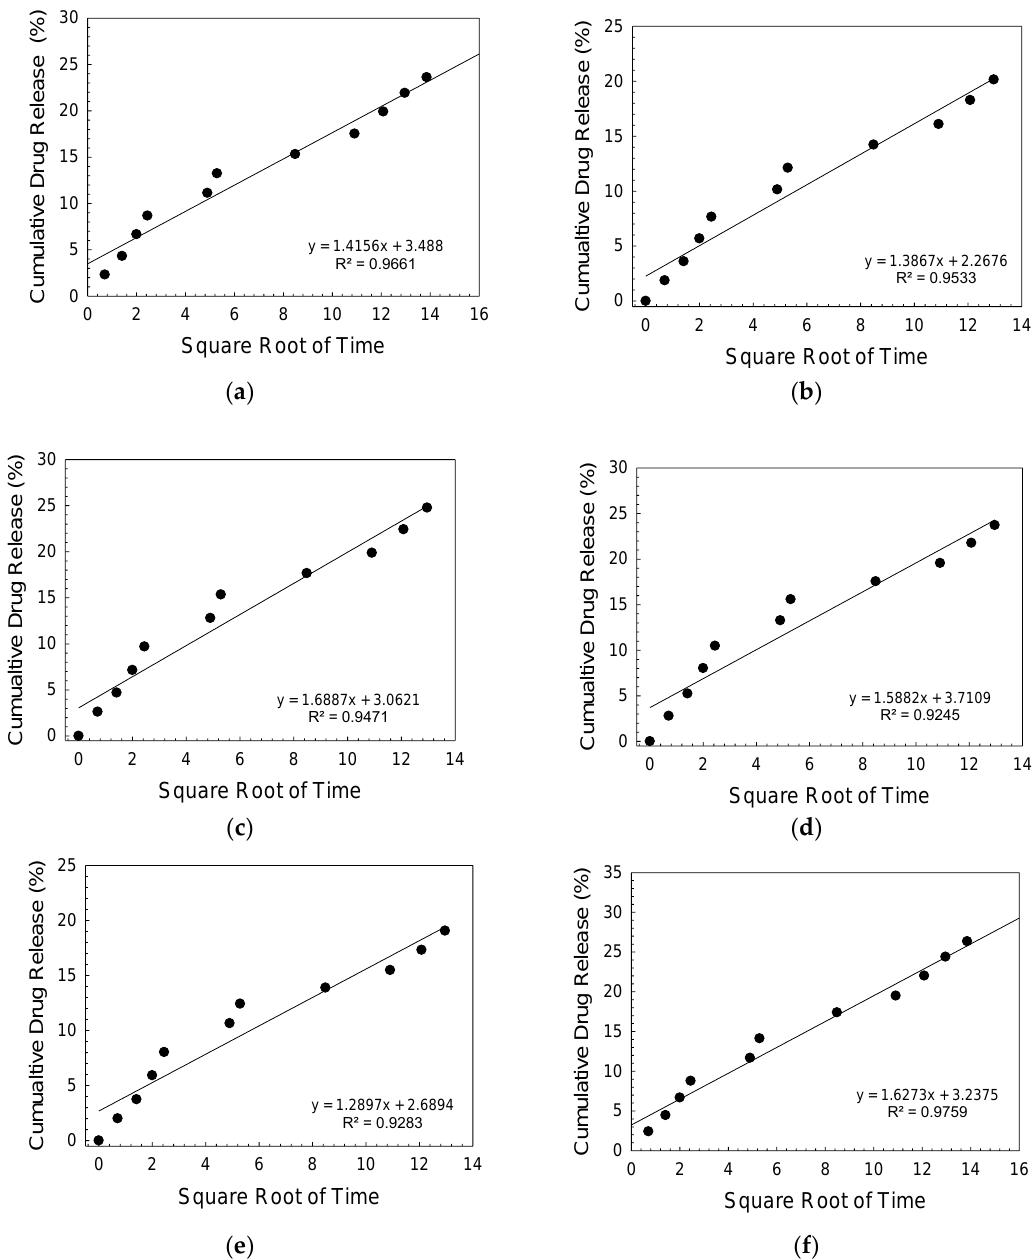
Figure 10. Graphs showing the Higuchi model 5-FU release for ( a ) bare B3, ( b ) 0.1 hBN-B3, ( c ) 0.2 hBN- B3, ( d ) 0.5 hBN-B3, ( e ) 1 hBN-B3, and ( f ) 2